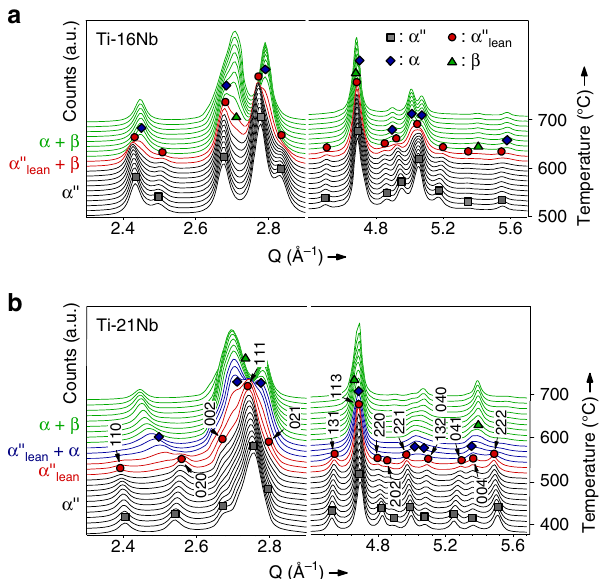
Fig. 4 Martensite decomposition. In situ synchrotron X-ray diffraction patterns during isochronal heating (10 °C min − 1 ) showing the decomposition of α ″ martensite into α and β phases for a Ti – 16Nb and b Ti – 21Nb. For Ti – 21Nb the re fl ections of α ″ lean are exemplarily (Fig. 3b). The smoothly changing